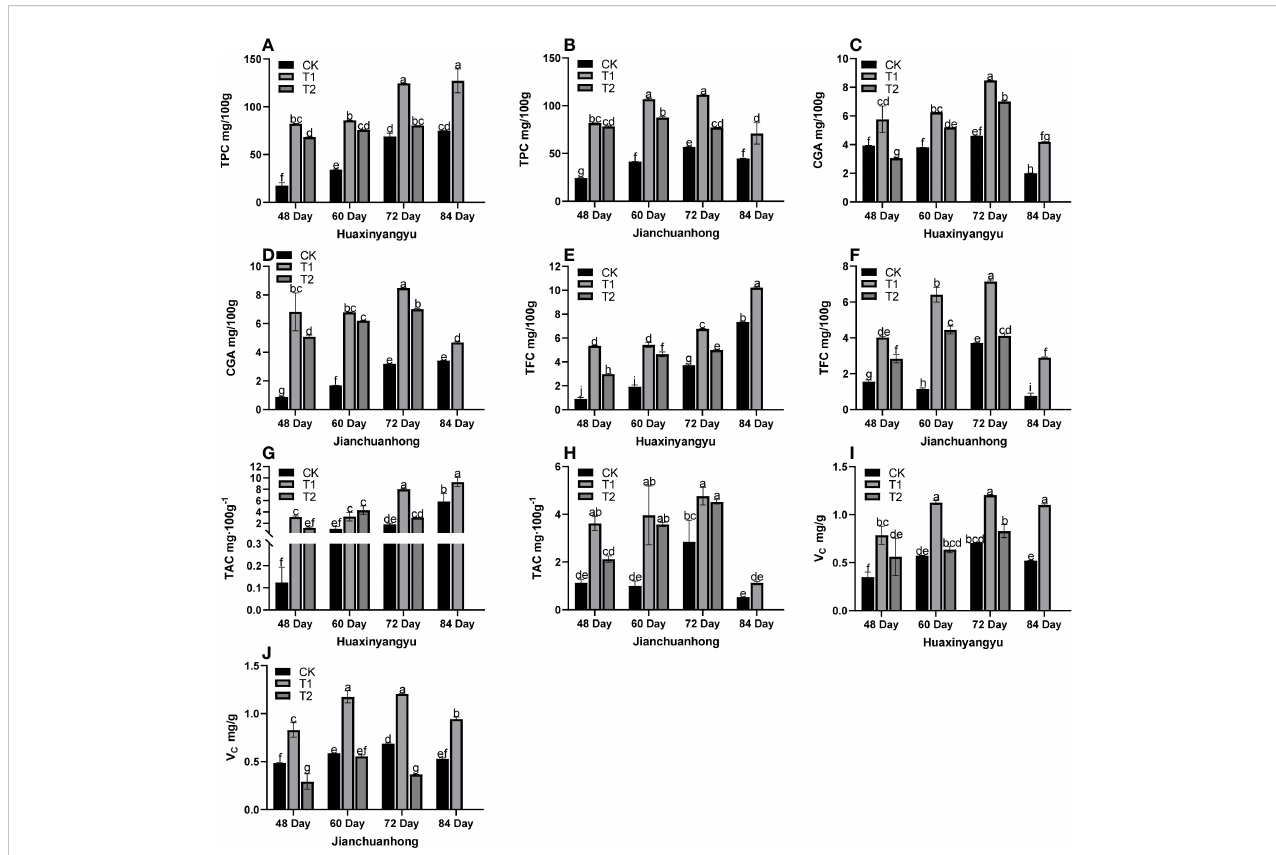
FIGURE 3 Analysis of the tuber nutrient composition of “ Huaxinyangyu ” and “ Jianchuanhong ” in the whole growth period with different UV-B treatments (A) the phenols content (TPC) of “ Huaxinyangyu “ , (B) the phenols content (TPC) of “ Jianchuanhong ” , (C) the chlorogenic acids (CGA) of “ Huaxinyangyu ” , (D) the chlorogenic acids (CGA) of “ Jianchuanhong ” , (E) the fl avonoids content (TFC) of ” Huaxinyangyu ” , (F) the fl avonoids content (TFC) of ” Jianchuanhong ” , (G) the anthocyanins content (TAC) of “ Huaxinyangyu ” , (H) the anthocyanins content (TAC) of “ Jianchuanhong ” , (I) the vitamin C (V C ) of “ Huaxinyangyu ” , (J) the vitamin C (V C ) of “ Jianchuanhong ” , (According to the Duncan test, different letters indicate a signi fi cant difference (p< 0.05) among the treatments. The error bars represent the mean ± SE. The x-axis represents a variety of names, and the Y axis represents compound